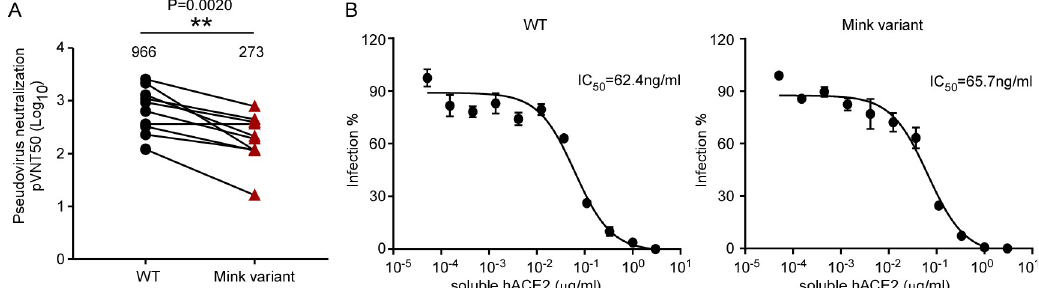
Fig 7. Sensitivity of miSARS-CoV-2 “Cluster Five” spike pseudotyped virus to neutralization by convalescent sera of patients or soluble ACE2. (A) Convalescent serum samples from donors were serially diluted and incubated with WT or “Cluster Five” spike-pseudotyped viruses. The serum dilution factor leading to 50% reduction of pseudotyped virion entry was calculated as the NT 50 (neutralizing titer 50). Identical plasma samples are connected with lines. These analyses were repeated twice with similar results. Statistical analysis of the difference between neutralization of the WT and “Cluster Five” was performed using two-tailed Wilcoxon matched-pairs signed-rank test. (B) Recombinant ACE2-Ig was diluted at the indicated concentrations. Viral entry was determined by assessing Luc activity 48 hours post infection. The dilution factors leading to 50% reduction of pseudotyped virion entry was calculated as the IC 50 . Data shown are representative of three independent experiments with similar results, and data points represent mean ± SD in triplicate.